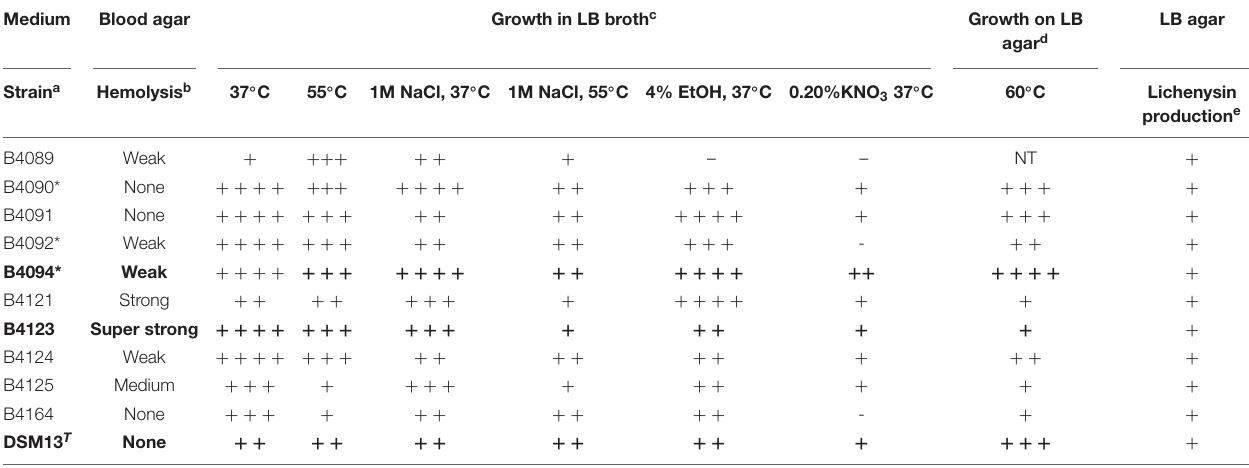
TABLE 1 | Properties of Bacillus licheniformis food isolates and the type strain DSM13 T . Medium